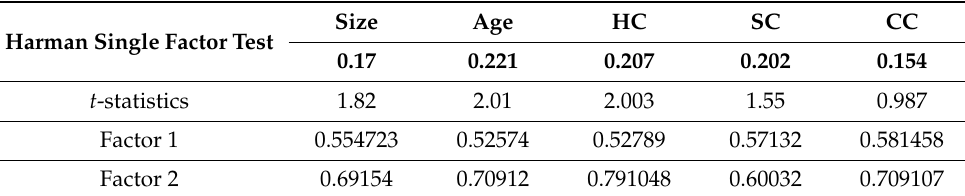
Table 5. Harman single factor